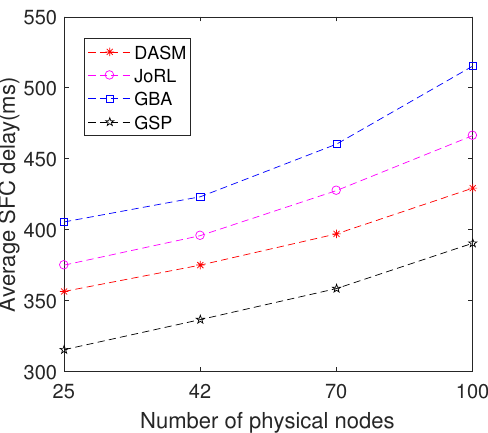
Figure 6. Average SFC delay with the increasing topology scales.